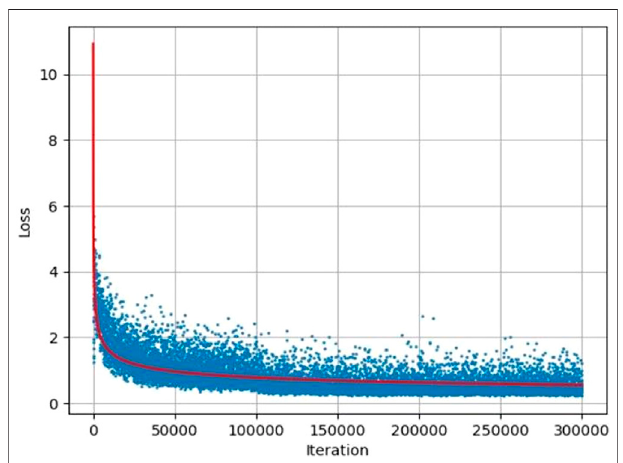
FIGURE 7 | Loss by iteration for a training run with 300 k iterations.